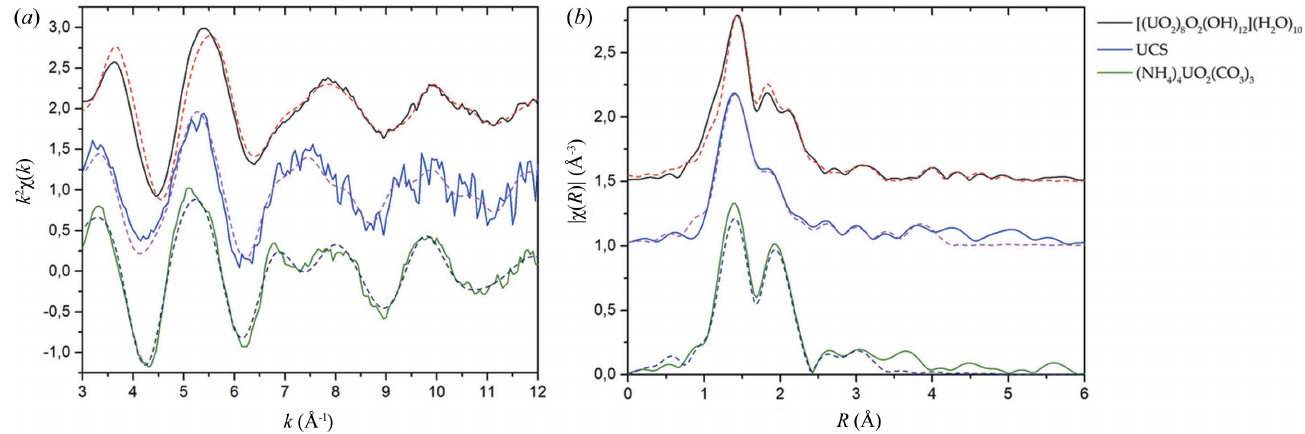
Figure 3 ( a ) U L III -edge k 2 -weighted EXAFS spectra of the UCS sample with schoepite and carbonate standards; ( b ) Fourier transform magnitude, not corrected for phase shifts. The dotted lines represent fit